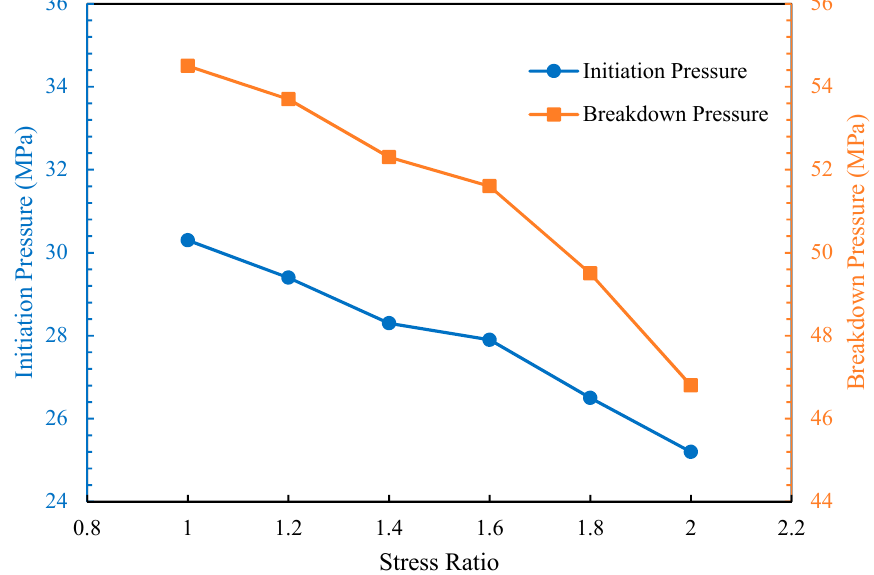
Figure 10. Initiation and breakdown pressures with different stress ratios. Table 3. Initiation pressure and breakdown pressure for different stress ratios.